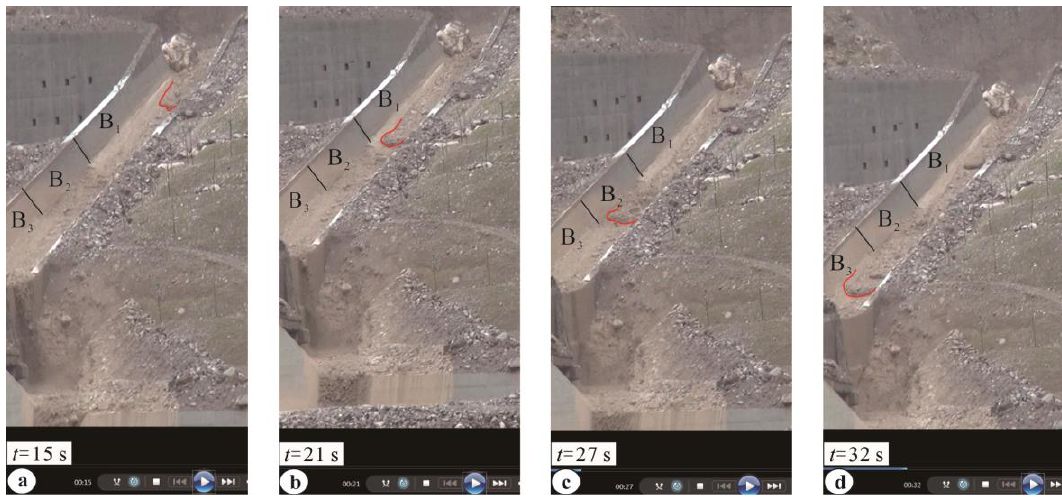
Figure 9. Observation of flow velocity change of debris flow in drainage channel (17 August 2012). Lengths of each section are LB 1 = 46 m, LB 2 = 20 m, LB 3 = 34.2 m.